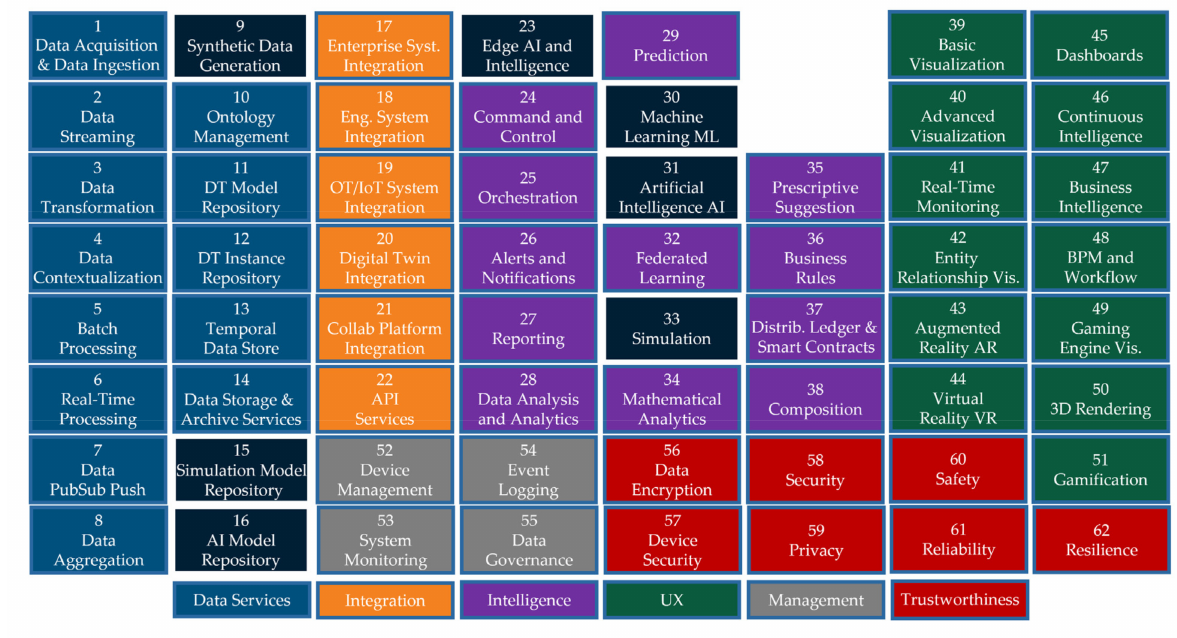
Figure 4. The digital twin capabilities periodic table